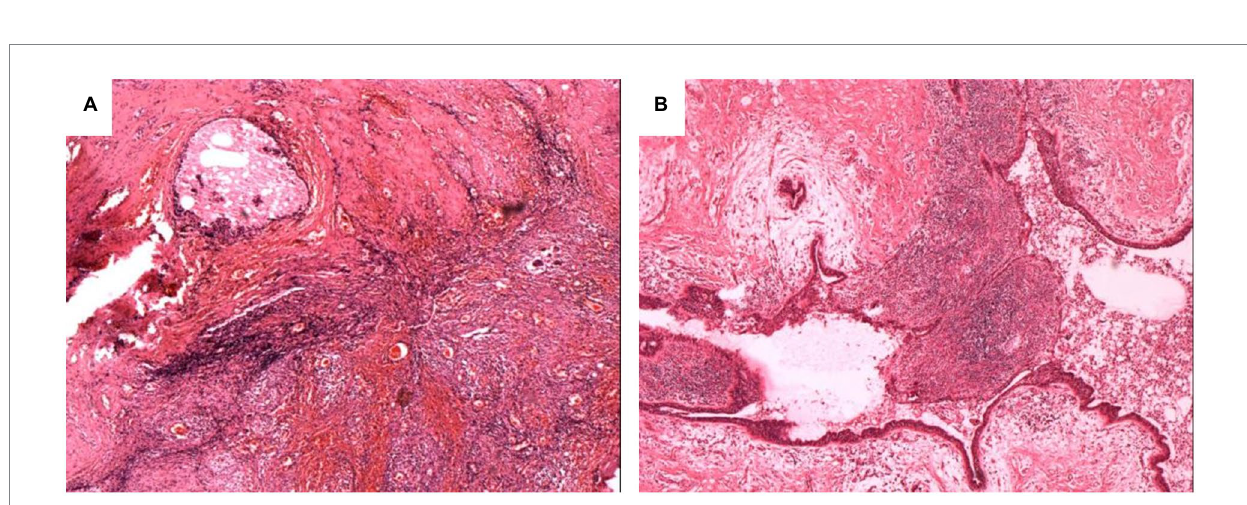
FIGURE 5 Pathological characteristics of PCM patient. More lymphocytes and plasma cells infiltrate around the large duct, and inflammatory cells can be seen in the lumen (A,B)